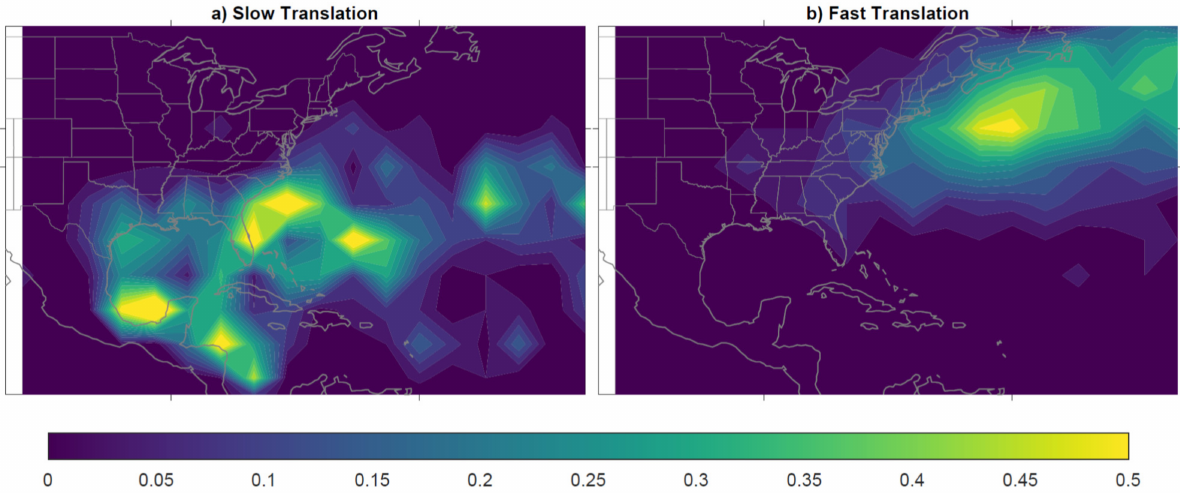
Figure 1. Annual mean density (shading; unit: events) of ( a ) slow and ( b ) fast tropical cyclone extreme translation events in the North Atlantic averaged over 1980–2019. The annual mean density of tropical cyclone extreme translation events is obtained by binning the tropical cyclone extreme translation events into 2 × 2 boxes during 1980–2019 divided by 40 (i.e., the number of years).